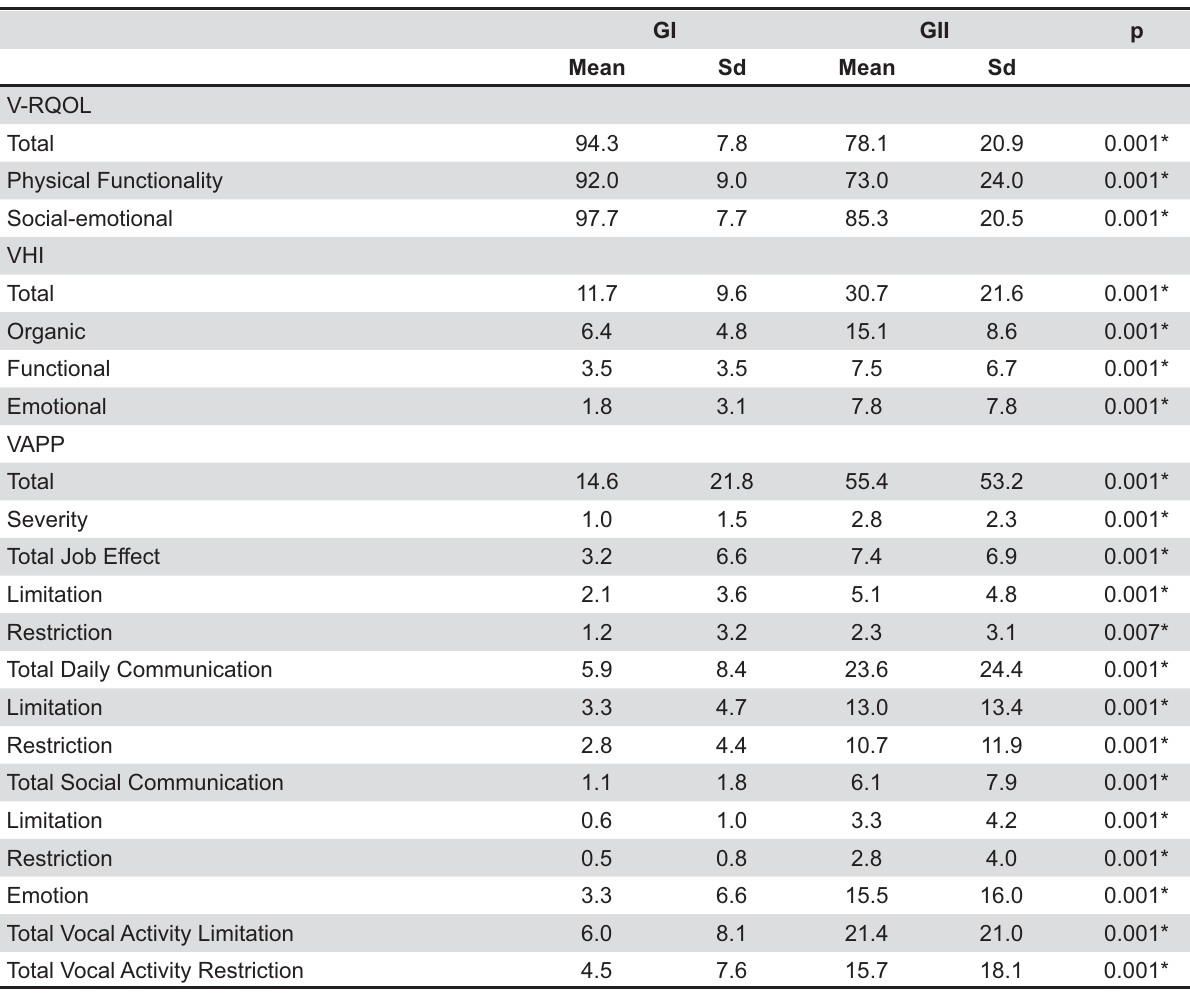
Table 1- Comparison of the results of psychometric tests between GI (reported no vocal alteration) and GII (reported vocal alteration)